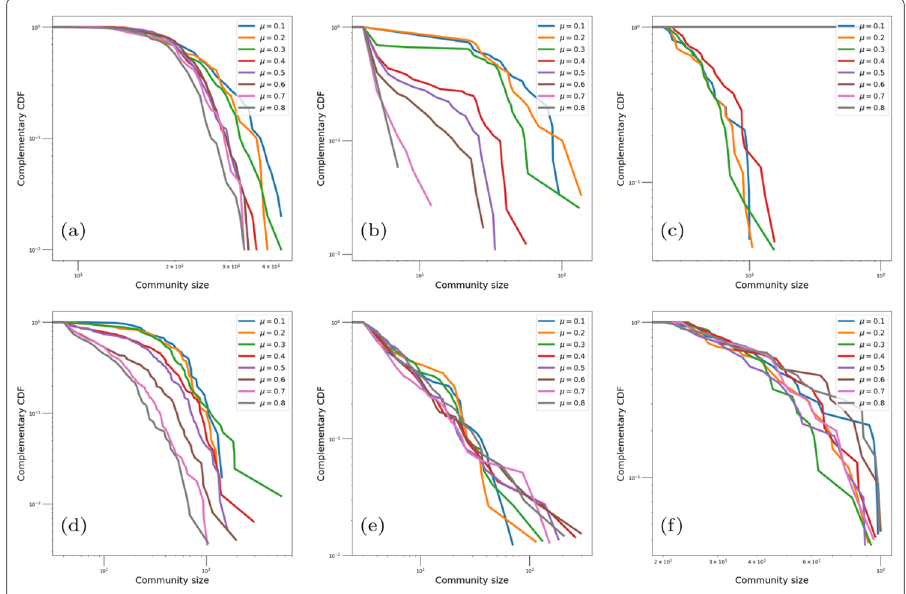
Fig. 20 Variation of mixing parameter ( μ ) for LFR synthetic networks considering the community size: a Bigclam; b CFinder; c Copra; d Demon; e SLPA; f